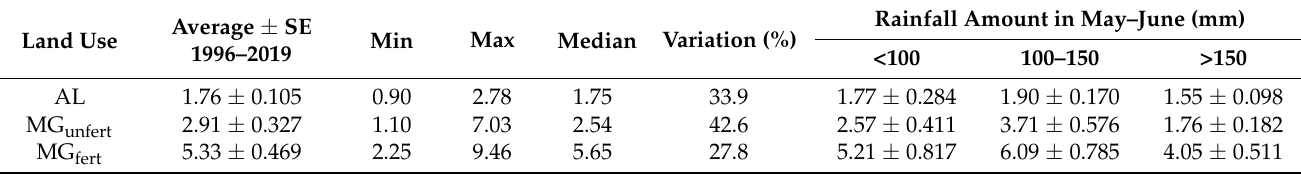
Table 2. Biomass mean values, standard error (SE), and amplitude of different grass phytocenoses (DM Mg ha − 1 ) in Arenosol (1996–2019).